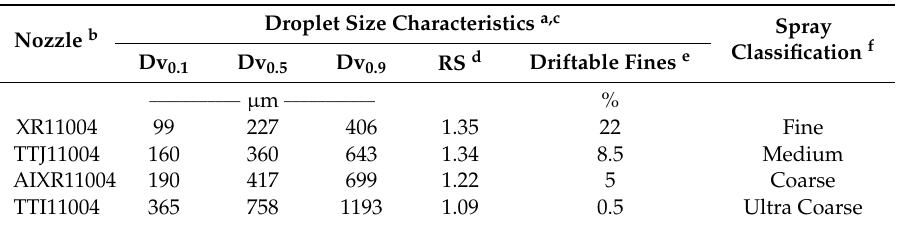
Table 2. Droplet size distribution and spray classification for four nozzle types using a glyphosate + dicamba tank mixture at 270